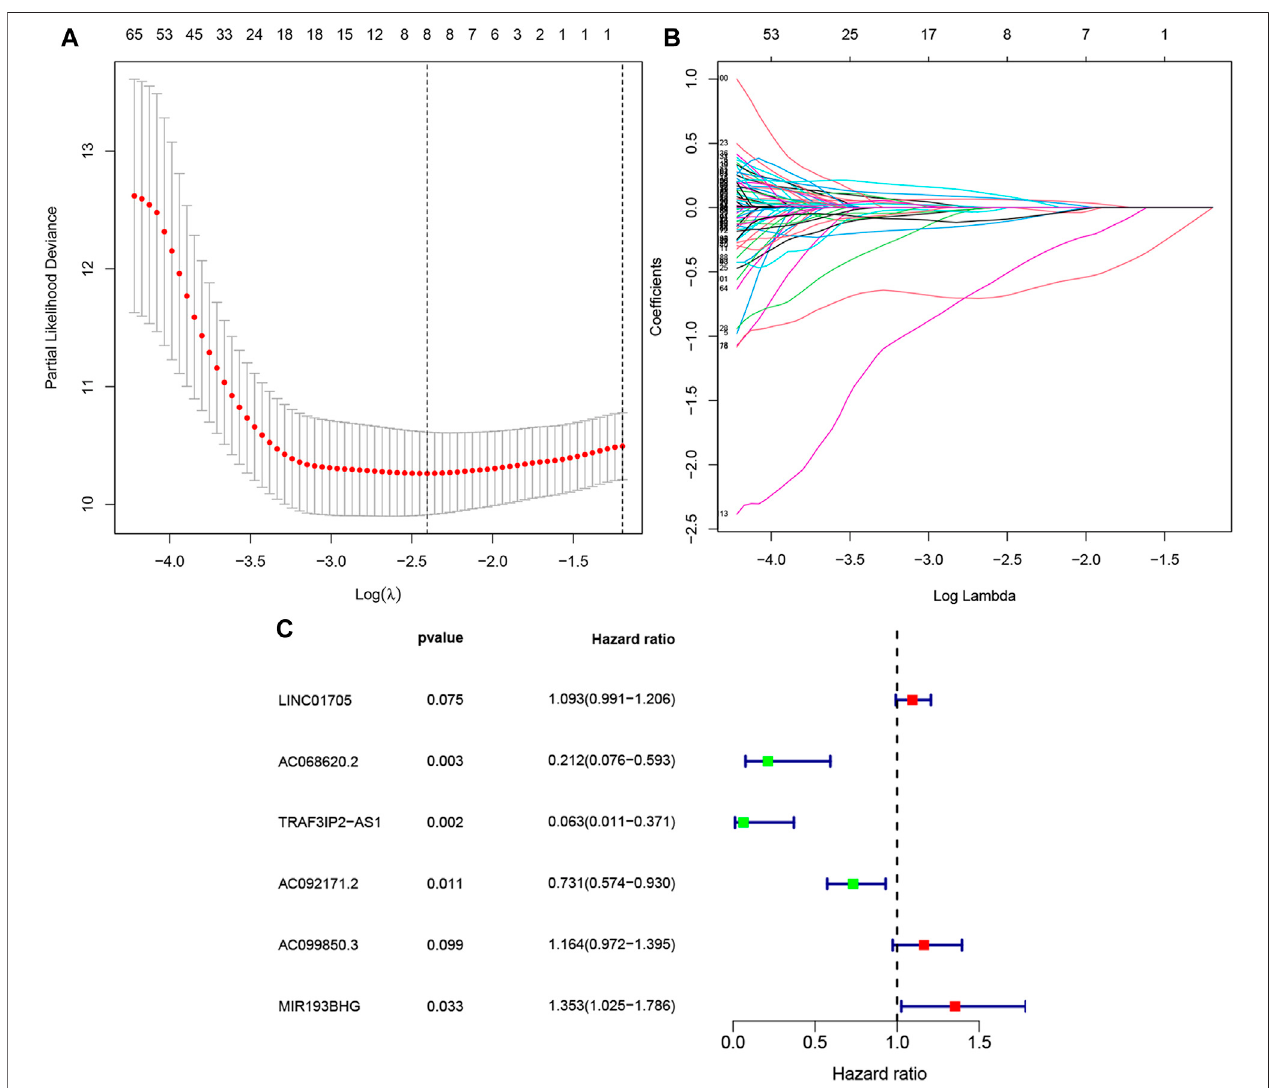
FIGURE2| SelectionofFRLsusingLASSOandmultivariateCoxregression. (A) EightFRLsbasedLASSOcrossvalidationplot. (B) LASSOcoef fi cientofeightFRLs in PAAD. (C) Multivariate Cox regression showing six FRLs (LINC01705, AC068620.2, TRAF3IP2-AS1, AC092171.2, AC099850.3, and MIR193BHG) associated with OS in TCGA-PAAD.